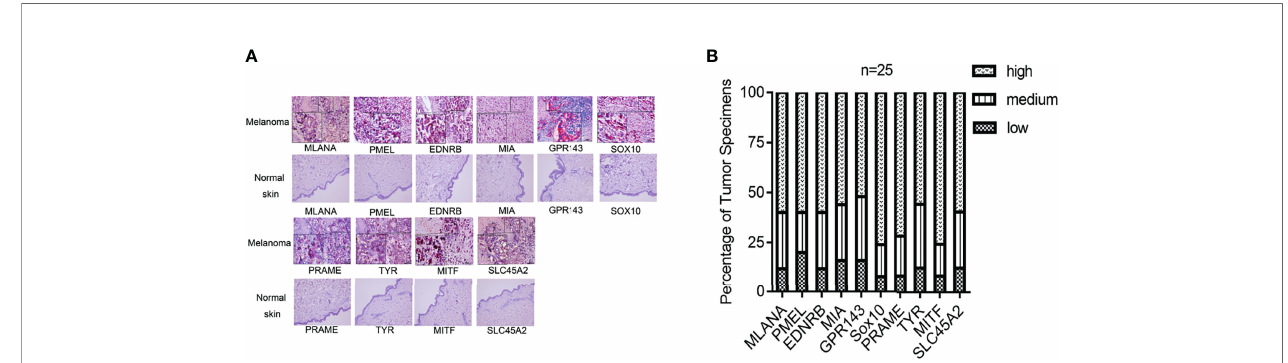
FIGURE 9 | Gene expression of the hub genes in melanoma tissue and normal skin specimens. Using IHC staining, all the hub genes ( MLANA, PMEL, EDNRB, MIA, GPR143, SOX10, PRAME, TYR, MITF , and SLC45A2 ) are expressed at higher levels in the melanoma tissue ( n = 25) when compared to normal skin. (A) IHC staining. (B) Quanti fi cation of the protein levels of the hub genes in melanoma tissues. IHC: Immunohistochemistry. IHC stain, AEC, original magni fi cation: 100 × (inset, IHC stain, AEC, original magni fi cation: 400